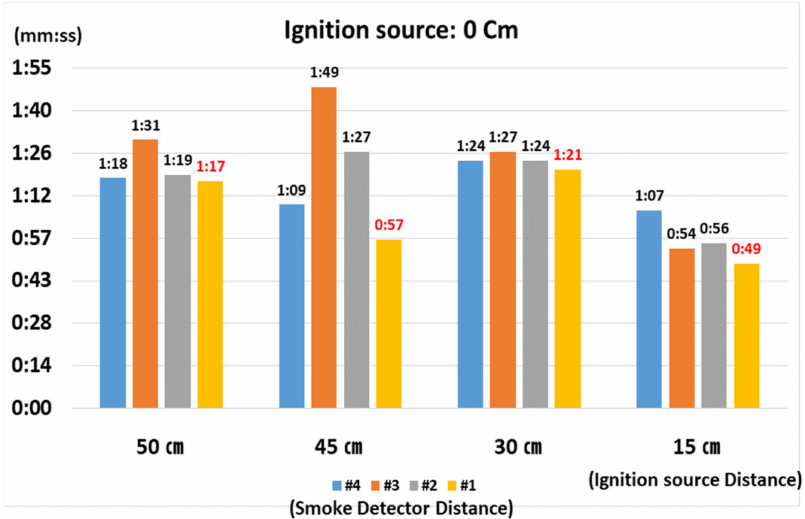
Figure 12. Elapsed time until smoke detection for ignition source height of 0 cm.